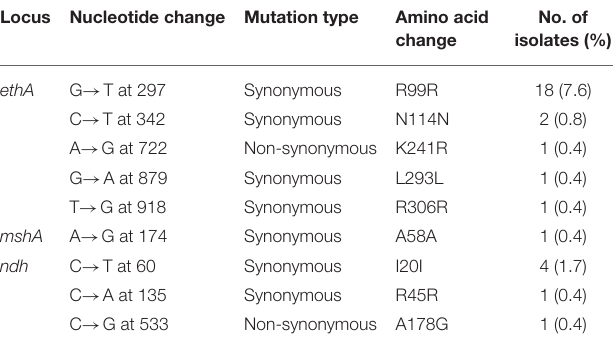
TABLE 6 | Mutations in ethA , mshA , and ndh in 236 PTH-susceptible MTB isolates. Locus Nucleotide change Mutation type Amino acid